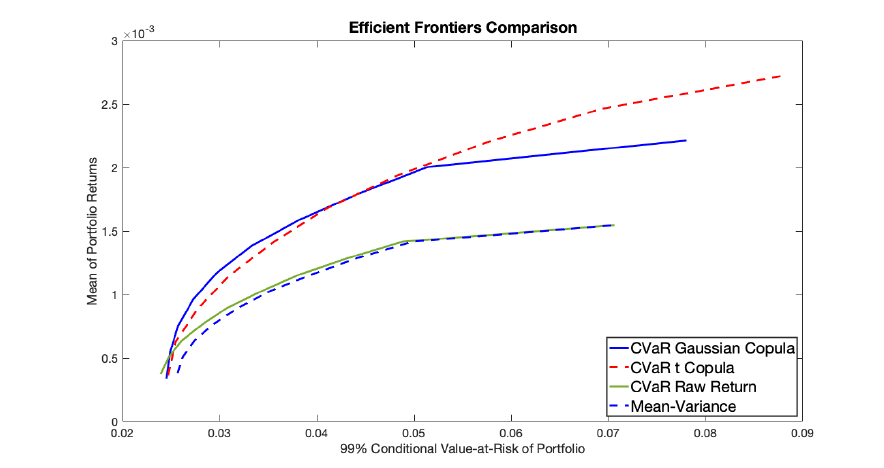
Figure 6. Mean-CVaR efficient frontiers with 99% CVaR (23 random